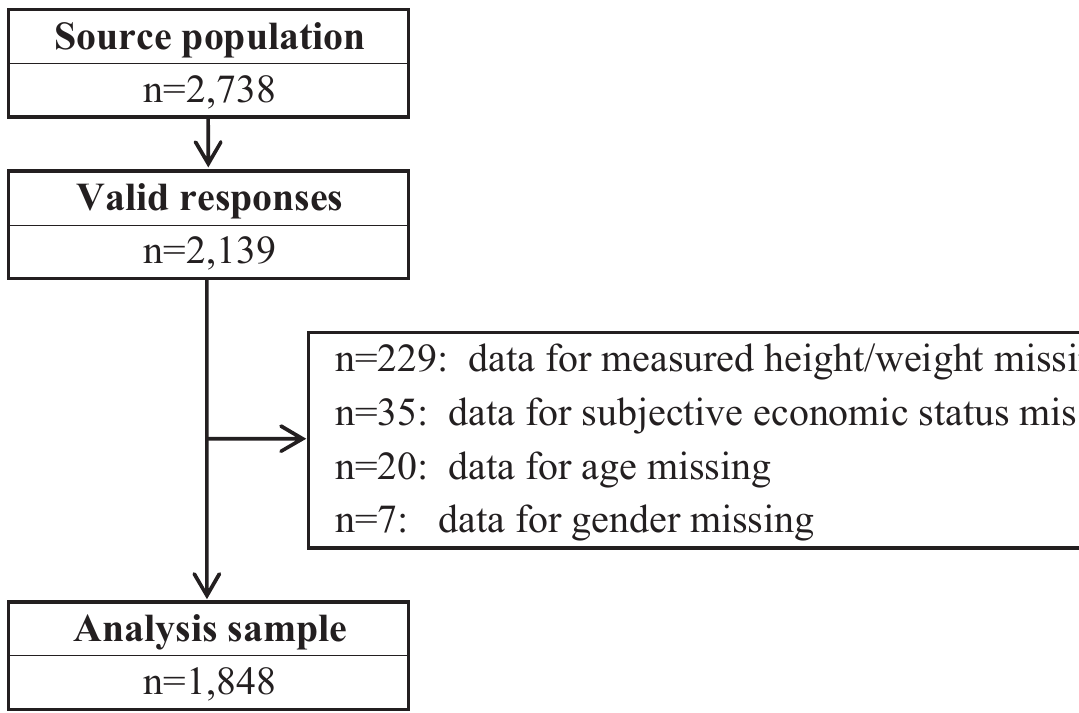
Figure 1. Flow chart of study